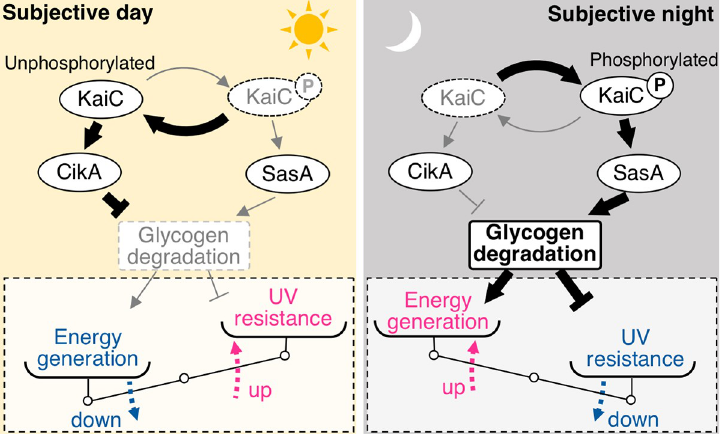
Fig 6. Schematic diagram of a possible trade-off between UV resistance and energy metabolism in Synechococcus . The results of the present and previous studies show an inverse correlation between UV resistance and glycogen degradation. High UV resistance at any time of the day would require continuous suppression of glycogen degradation, which must be disadvantageous to energy utilization in order to survive in the dark. Such a trade-off would give rise to the necessary use of different physiological functions in a time-dependent manner. Priority would be given to UV resistance in the daytime when UV irradiation is present, whereas energy production via glycogen degradation in the night occurs when photosynthesis is interrupted. Such a time-dependent trade-off is plausibly controlled by the output pathways mediated by the SasA and CikA from the Kai-based central